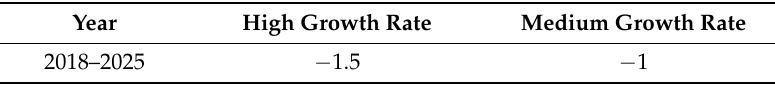
Table 4. Power structure growth rates of China from 2018 to 2025